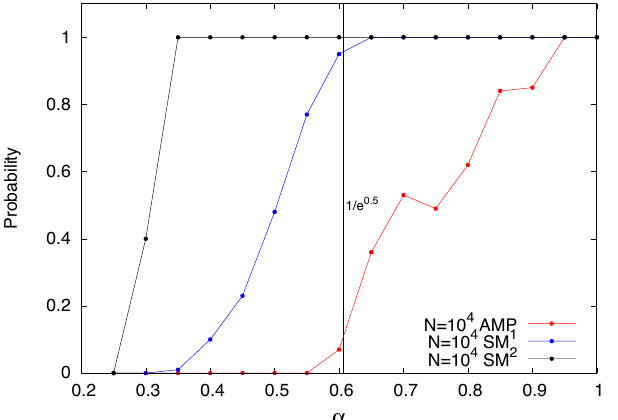
Figure 10. The picture shows the probability of success for recovering the hidden clique as a function of α for AMP (red points), SM 1 with early stopping (blue points) and SM 2 with early stopping (black points). Points are α √ N ) for AMP algorithm and SM 1 with early stopping, 10 4 , p 0.5, K HC averages over 100 graphs G ( N = = = while they are an average over 5 graphs for SM 2 with early stopping.